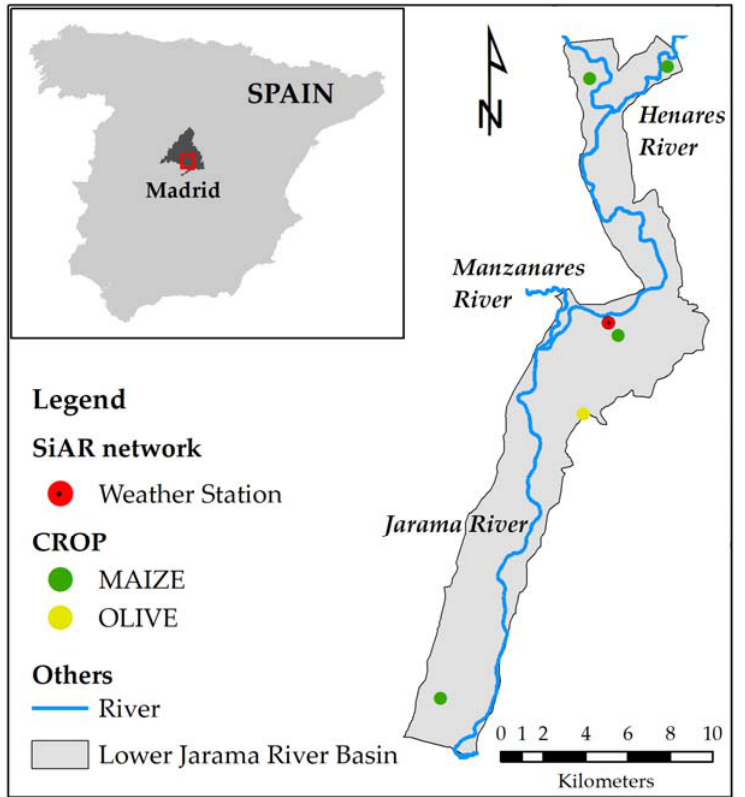
Figure 1. Lower Jarama River Basin, maize, olive and weather station location.